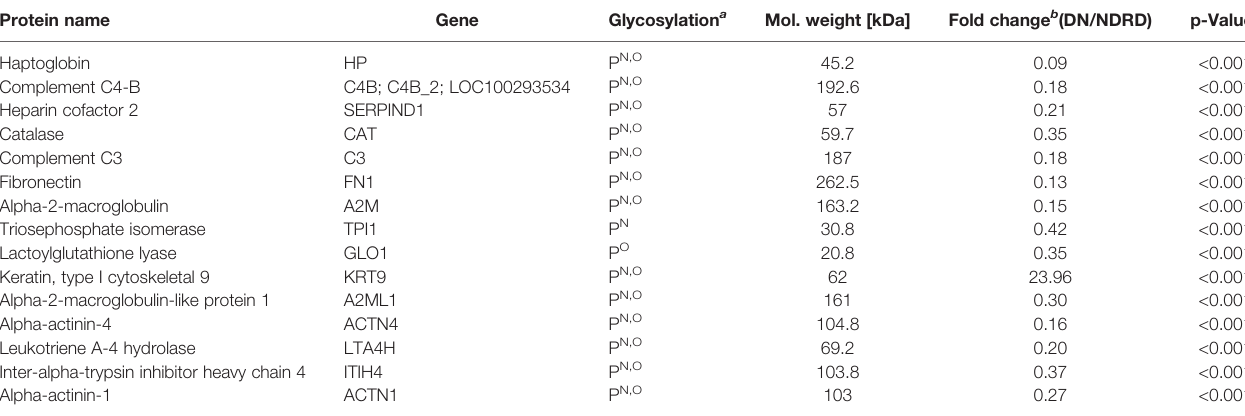
DN, diabetic nephropathy; NDRD, non-diabetic renal disease. a The potential N-linked and potential O-linked glycoproteins are analysed using software NetNGlyc 1.0 and NetOGlyc 4.0 Servers and shown as “ P N ” and “ P° ’ ; protein without typical glycosylation site is shown as “ N ” . b The protein expression level between NDRD and DN was compared and represented using the fold change. The signi fi cant differences is setting with fold change > 2 or < 0.5 and p < 0.001. c p-Value was calculated by two-tailed Student ’ s